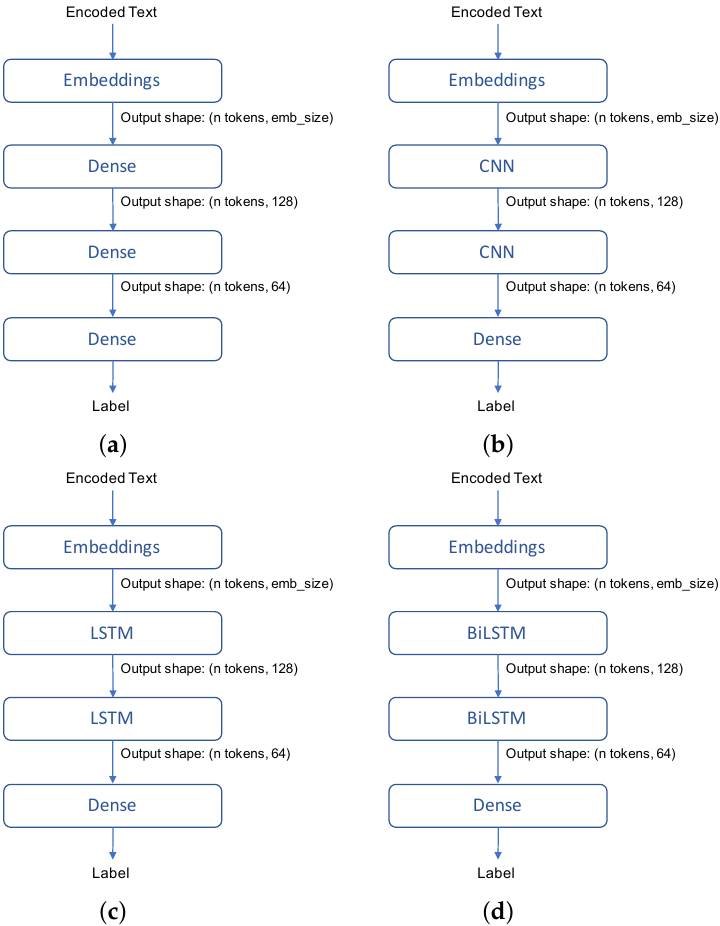
Figure 1. The deep learning models. ( a ) Dense ( b ) Convolutional Neural Network (CNN) ( c ) Long- Short Term Memory (LSTM) ( d ) Bidirectional LSTM. The output shape of the employed layers is indicated within the